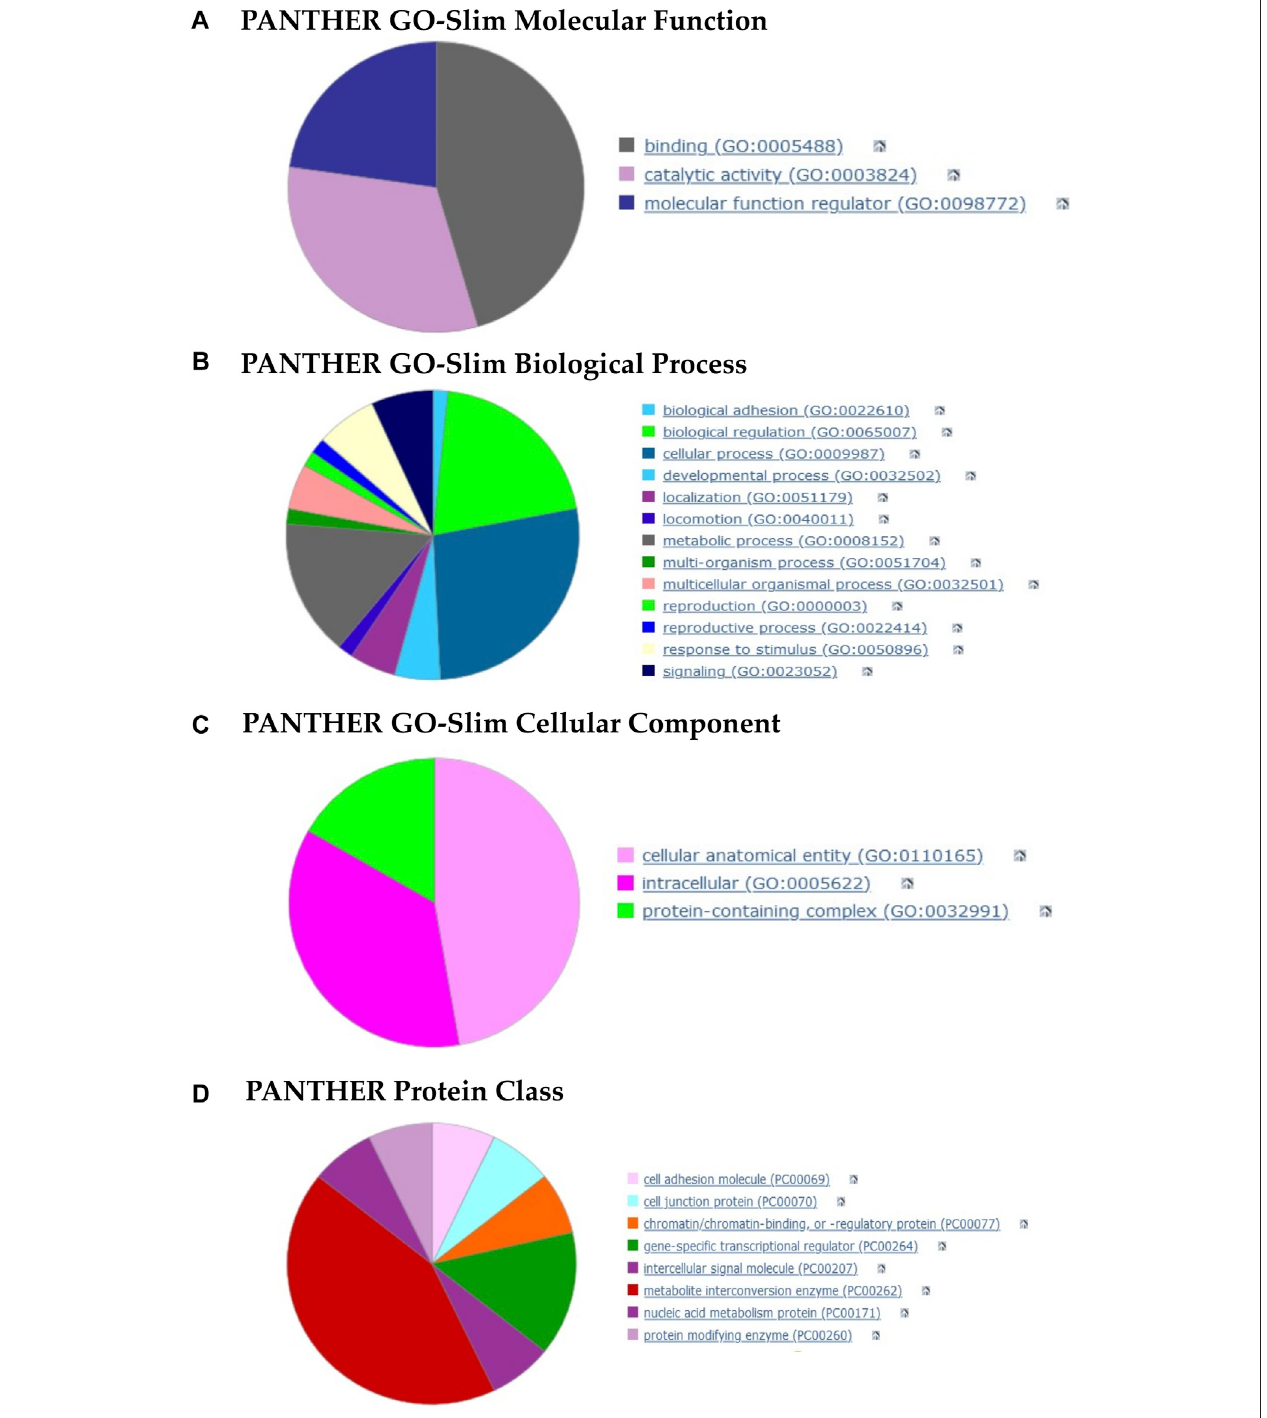
FIGURE7| Piechartsofgenefunction analysisbasedonthetRFstargets andperformedwithPANTHER. (A – C) Analysisofthe3GOaspects (molecularfunction, biological process, cellular component). (D) PANTHER Index terms describing protein classes (panther classi fi cation). The detailed terms for each category are summarized in the Supplementary File SC